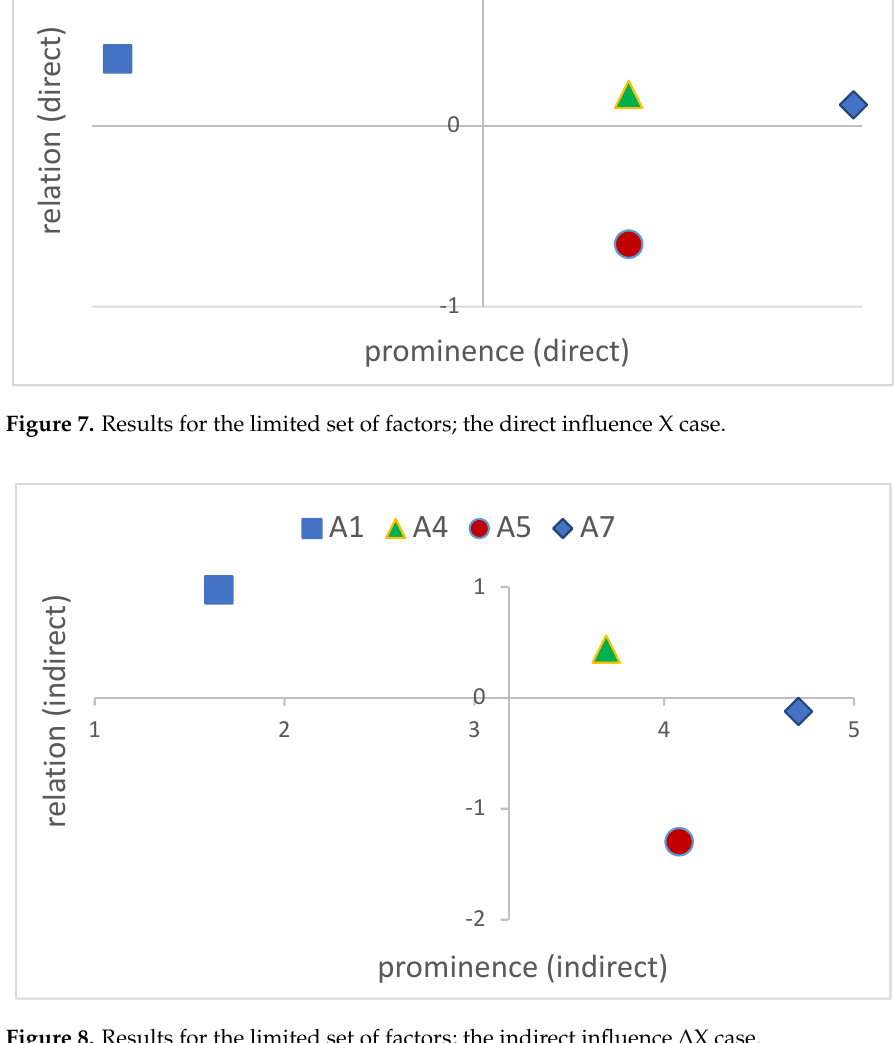
Figure 9. Results for the limited set of factors; the total influence T case.